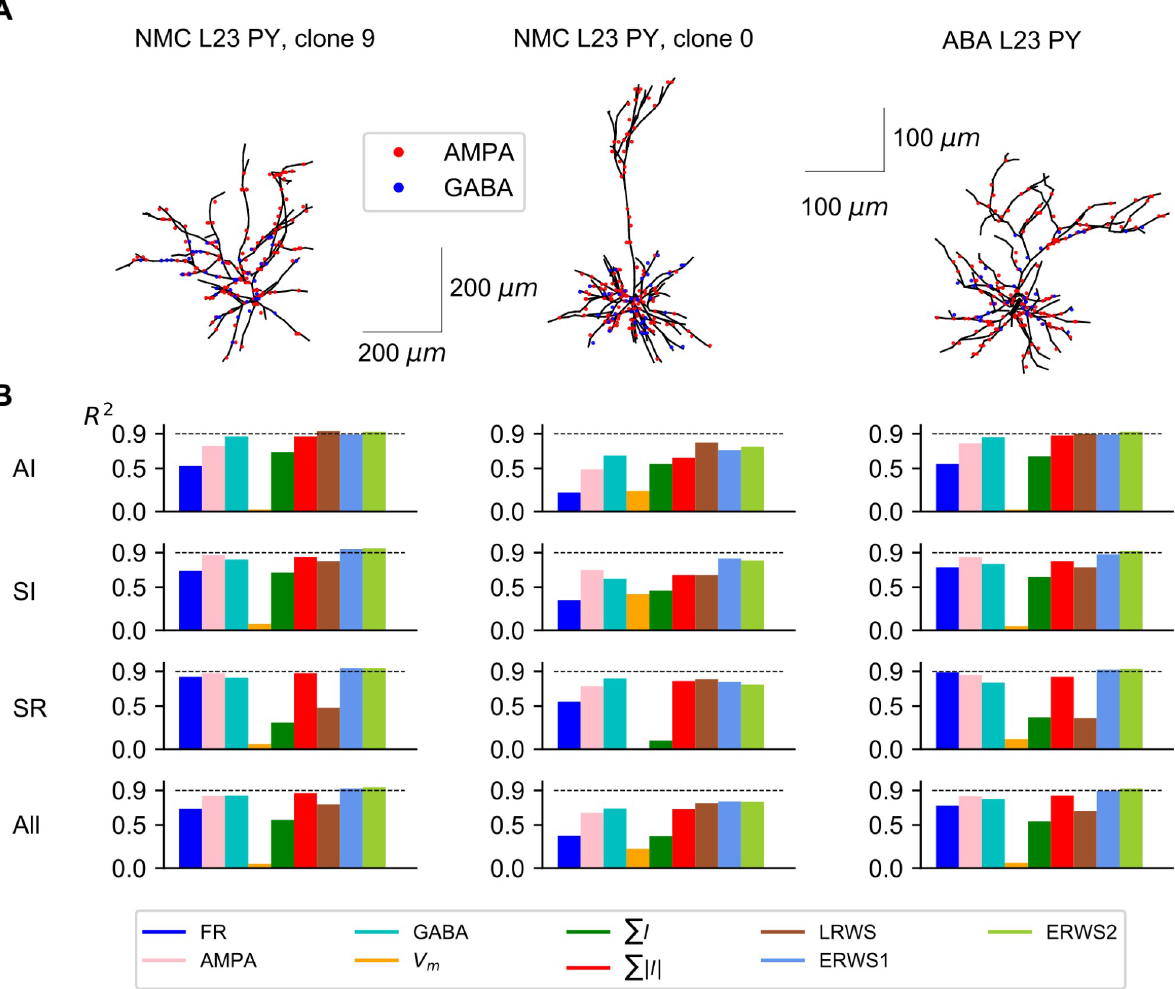
Fig 4. Performance of proxies for different morphologies. (A) Neuron reconstructions of L2/3 pyramidal cells acquired from the Neocortical Microcircuitry (NMC) portal [47,48]and the Allen Brain Atlas (ABA) [51]. For visualization purposes, in the synaptic distribution of each morphology, only a subset of AMPA and GABA synapses are shown, drawn randomly from all presynaptic connections. (B) R 2 computed for each morphology (columns) and network state (rows). The label “All” indicates the average R 2 across the three network